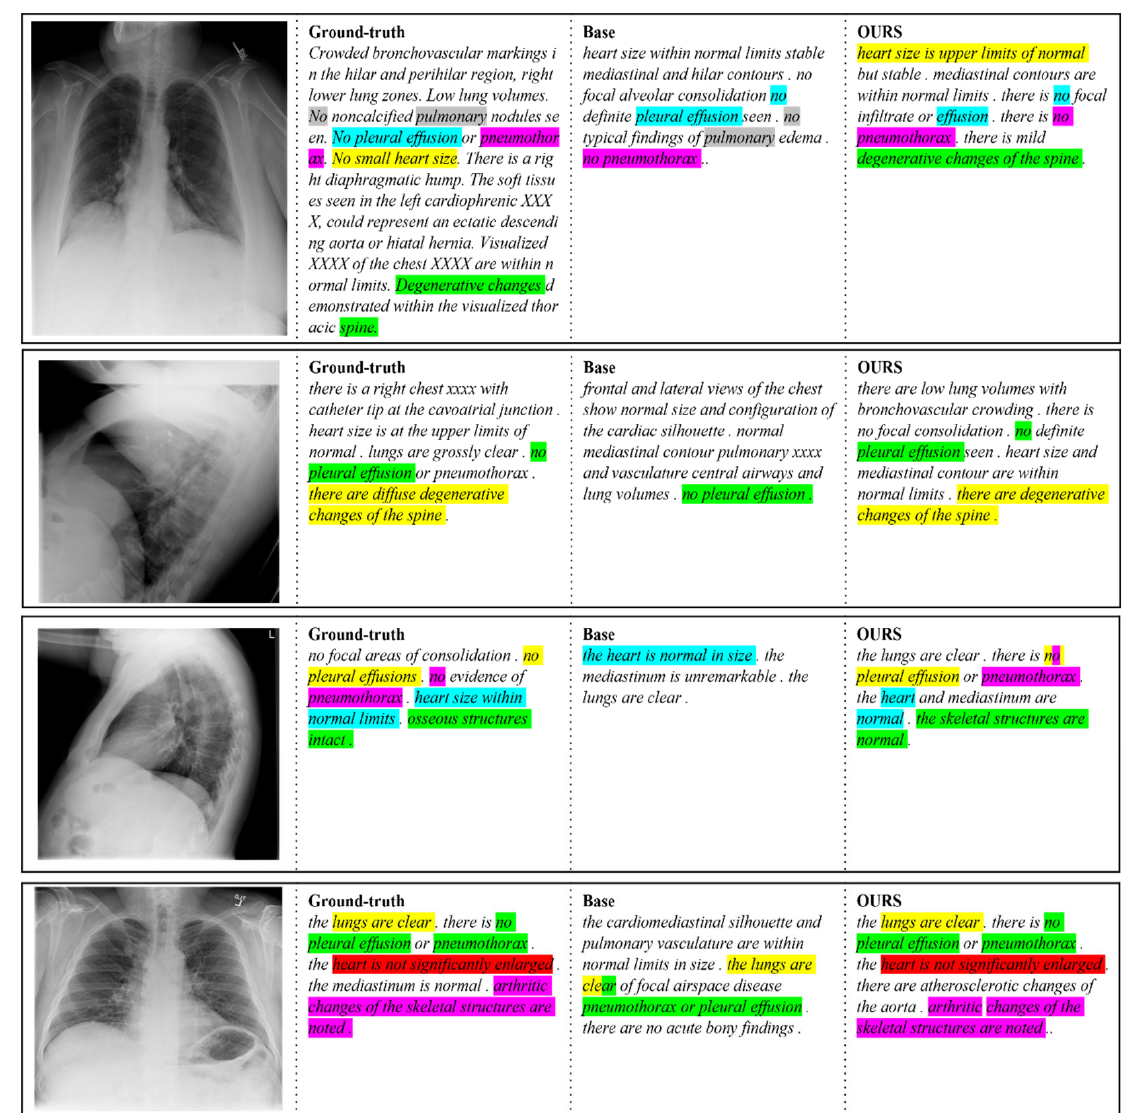
Figure 6. Ground-truth, the baseline report, and the report generated with the CEDT for two X-ray chest images. The same medical terms in the ground truth are highlighted with the same color in the generated text.